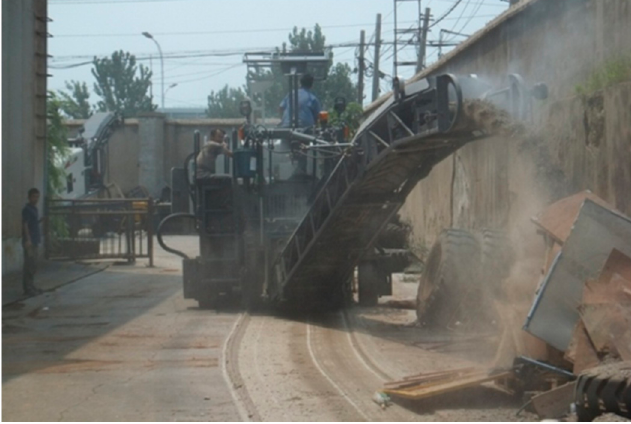
Figure 10. The field test of the cold milling machine.